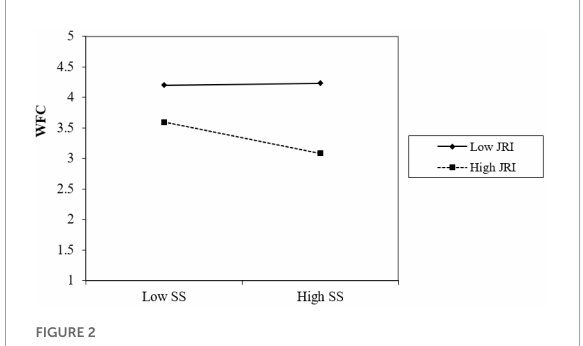
FIGURE2 The moderating role of job role